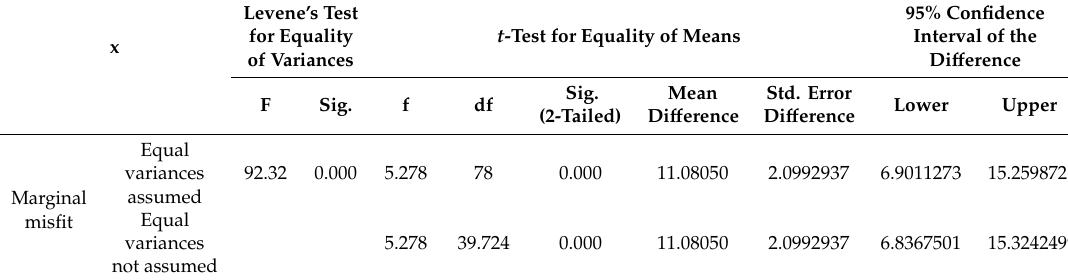
Table 3. Student’s paired t test.